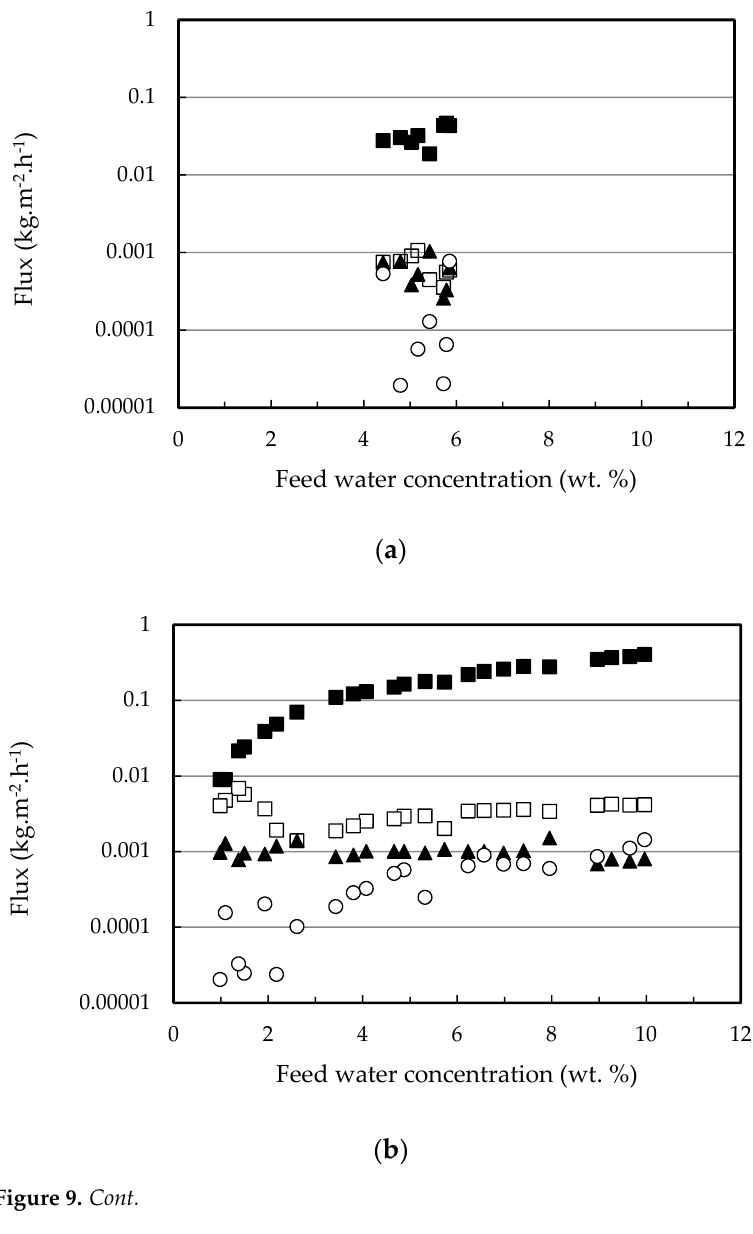
Figure 8. Water permeation fluxes (open symbols) and water concentration in permeate (closed symbols) as a function of feed water content for the PERVAP TM 1131 membrane at different temper ‐ atures: (  ,  ) T = 80 °C, (  ,  ) T = 60 °C, (  ,  ) T = 40 °C. Initial feed content: 13.5% lactic acid, 17.7% ethyl lactate, 10% water and 58.8%